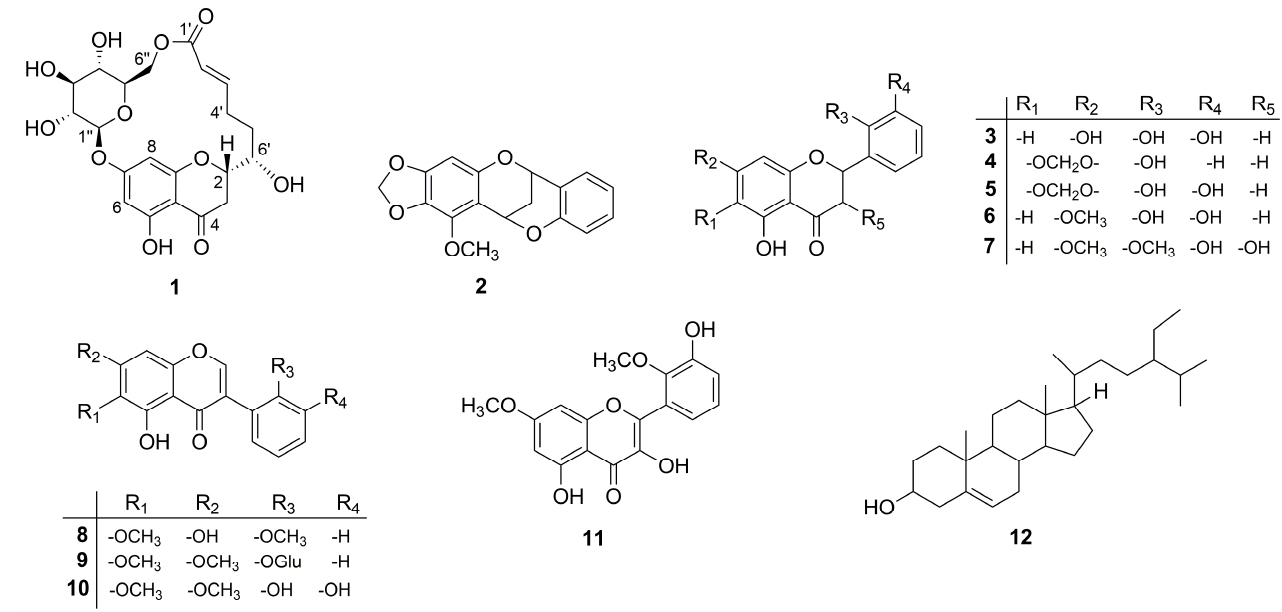
Figure 1. The structures of compounds 1–12 .